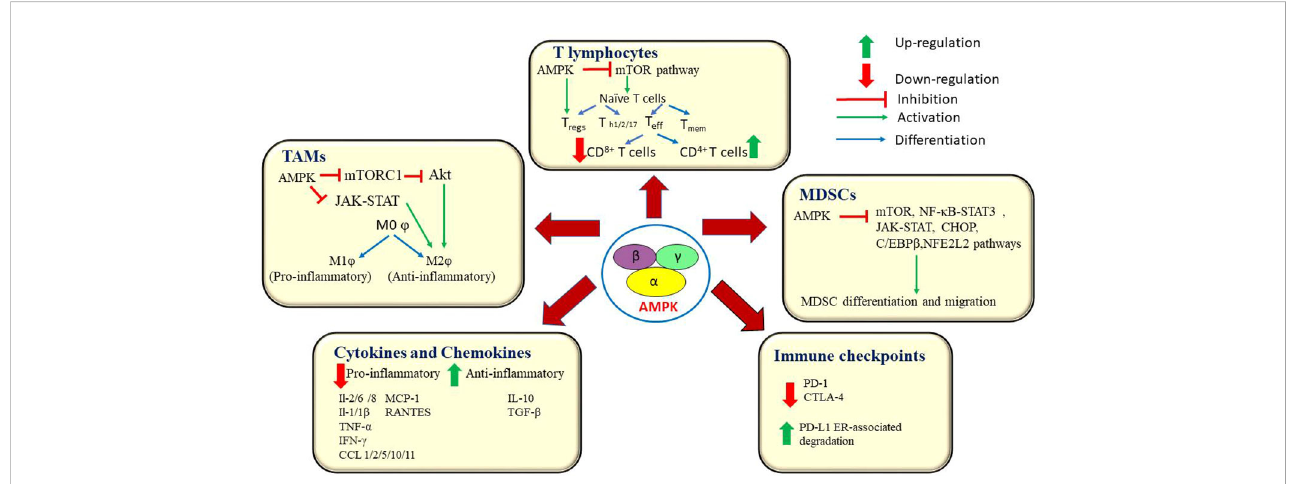
FIGURE 4 AMPK orchestrates an anti-tumor immune response by interacting with key players at the tumor microenvironment. AMPK in fl uences the functions of T lymphocytes, macrophages and myeloid-derived suppressor cells. AMPK down-regulates the production of pro-in fl ammatory cytokines and chemokines and blocks the immune checkpoint molecules, PD-1 and CTLA-4. AMPK, AMP-activated protein kinase; mTOR, mammalian target of rapamycin; Akt, A protein-serine/threonine kinase; mTORC1, mammalian target of rapamycin complex 1; T eff , Effector T cells; T mem , Memory T cells; T reg , Regulatory T cells; T h1/2/17 , Helper T cells1/2/17; PD-1, programmed cell death 1; IL-2/6/8/1/1 b , Interleukin 2/6/8/1/1 b ; TNF a , Tumor necrosis factor a ; IFN a , interferon gamma; PDL1, Programmed cell death ligand 1; CTLA-4, Cytotoxic T-lymphocyte – associated antigen 4; MCP-1, Monocyte chemoattractant protein -1; RANTES, Regulated upon activation, normal T cell Expressed, and Secreted; TGF- b , Transforming growth factor; MDSCs, Myeloid – derived suppressor cells; NF- k B, Nuclear factor kappa B; JAK/STAT, Janus kinase/signal transducers and activators of transcription; C/EBPR, CCAAT/enhancer – binding protein beta; CCL1/2/5/10/11, Chemokine (C-C motif) ligand 1/2/5/10/11; CHOP, C/EBP homologous protein; NFE2L2, Nuclear factor erythroid- derived 2-like 2; MO j , non – activated macrophage; M1 j , pro-in fl ammatory macrophage; M2 j , anti-in fl ammatory